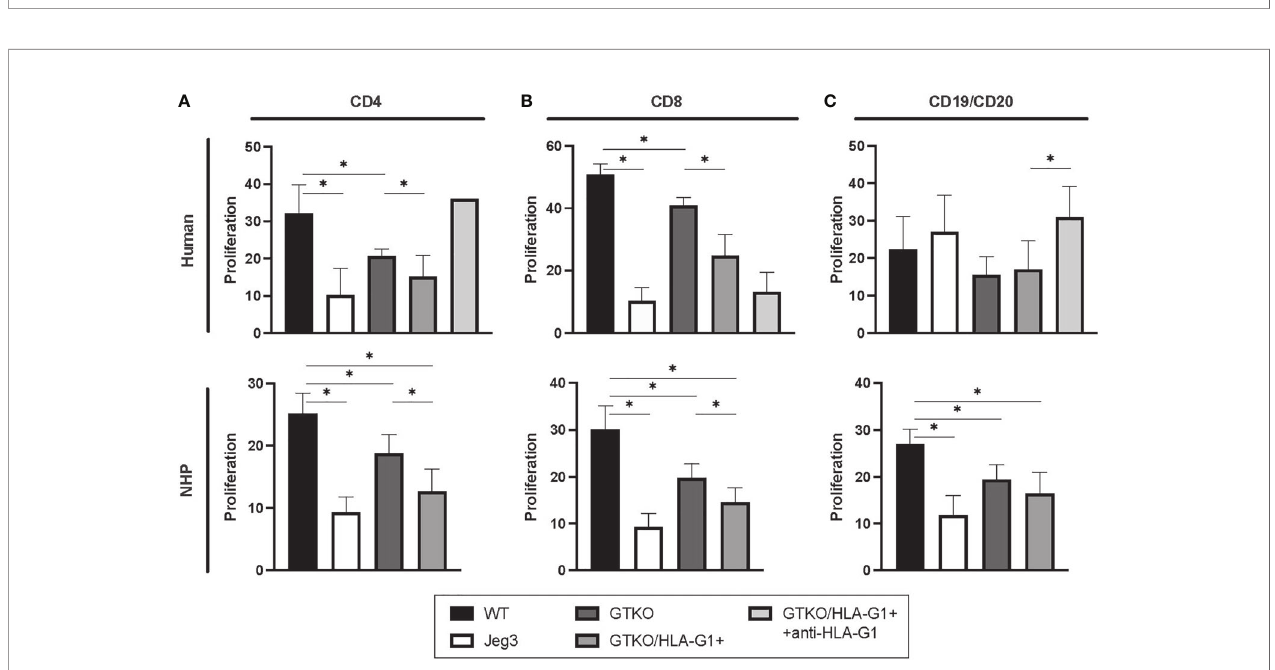
FIGURE 6 | Amelioration of hPBMC proliferation in vitro by skin fi broblasts obtained from HLA-G + transgenic pigs. (A) Proportion of CD4 + CFSE - T cells subset (B) Proportion of CD8 + CFSE - T cells subset (C) Proportion of CD19 + CFSE - subset. JEG3 cells were used as positive controls for HLA-G expression. Transgenic cells were treated with anti-HLA-G (87G) (5 µg/mL) for HLA-G blockade. Data shown are presented as mean ± SD.